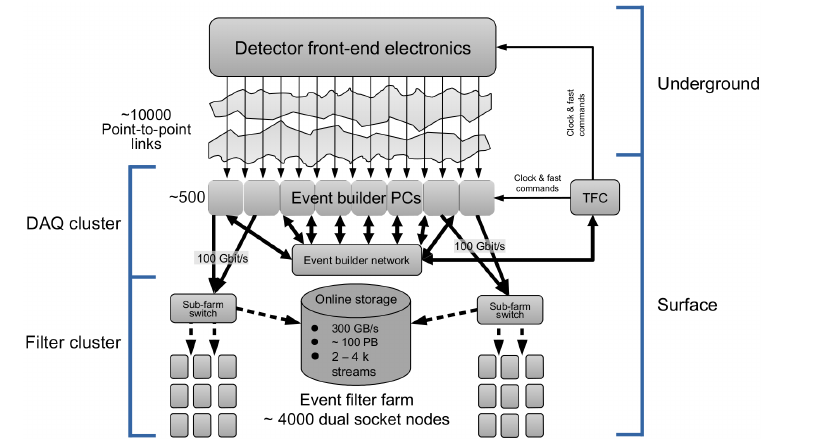
Figure 1. The architecture of the upgraded LHCb readout system. This diagram depicts the data flow from the front-end electronics, located 100 m underground, up to the long term data storage. This paper will investigate the architecture of the event builder, a more comprehensive description of the full DAQ chain can be found in